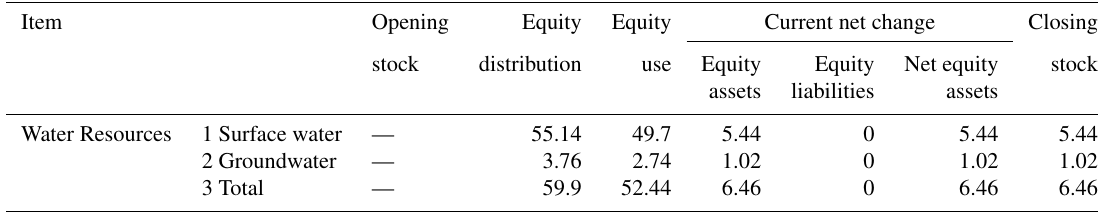
Table 3. Water resources equity balance sheet of Chengdu in 2015, measured in units of 100millionm 3 . Item